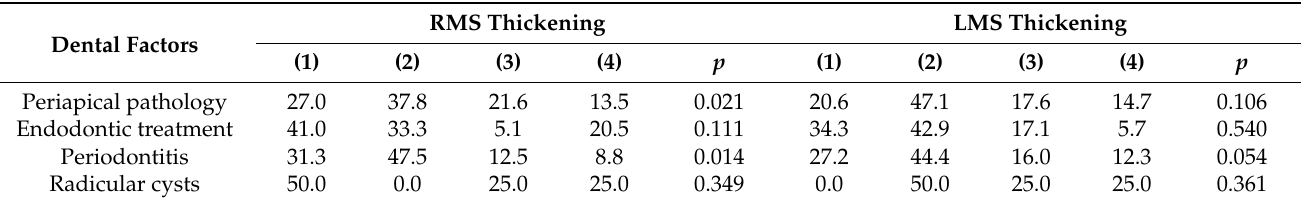
Table 6. Distribution, in percentages, of the thickening of the sinus membrane and its statistical association with dental